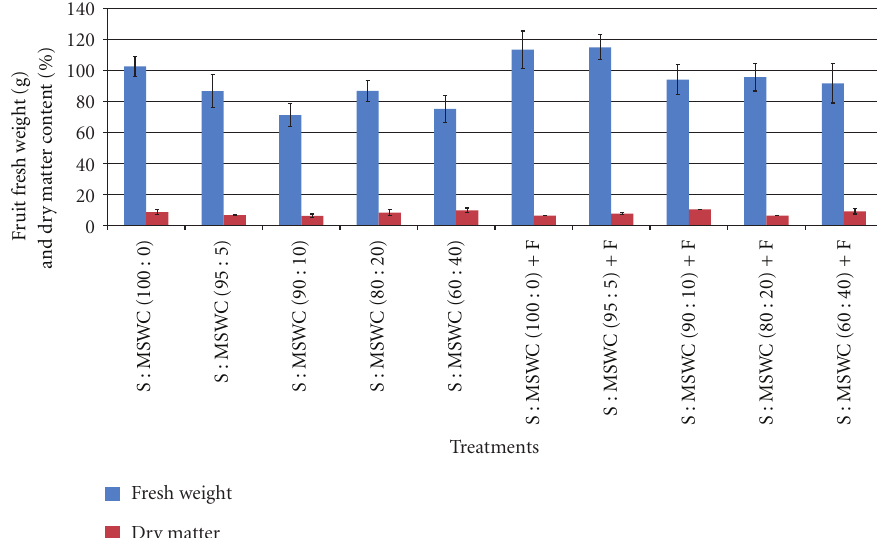
Figure 5: E ff ects of municipal solid waste compost (MSWC) into soil (S) without or with fertigation (F) on fruit fresh weight (g) and dry matter content (%) of greenhouse pepper crop. Values represent mean ( ± SE) of measurements made on average 23 fruits per treatment.